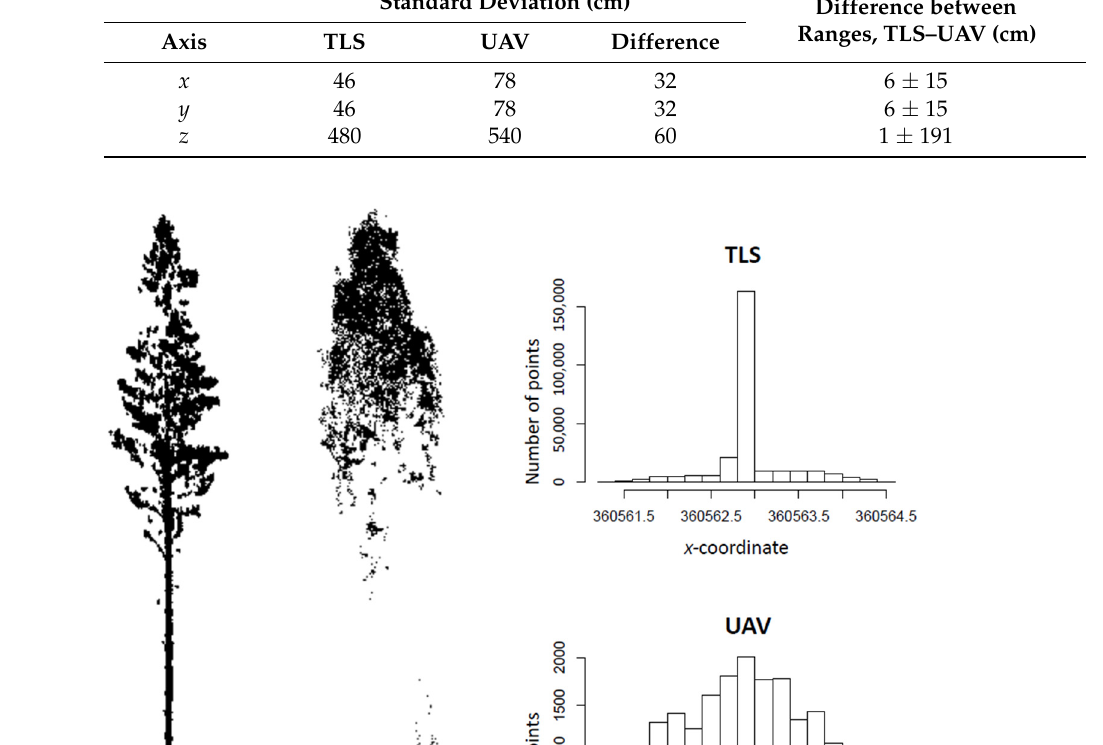
Table 10. On the left, the standard deviations of terrestrial laser scanning (TLS) and unmanned aerial vehicle (UAV) measured points with respect to all axes, and on the right, the difference between the ranges with standard deviations (UAV measured ranges subtracted from TLS measured). Standard Deviation (cm) Difference between Ranges, TLS–UAV (cm) Axis TLS UAV